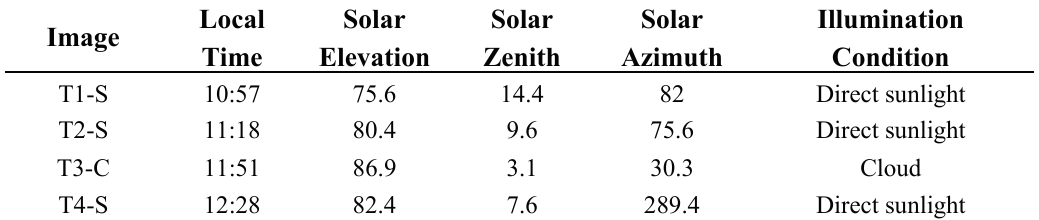
Table 2. Conditions of illumination under which images were